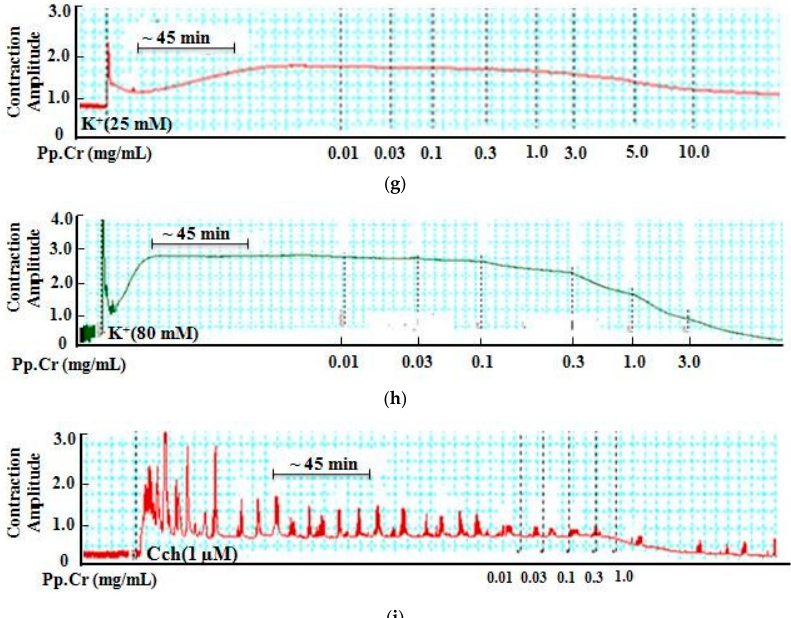
Figure 1. HPLC chromatogram acquired at 254 nm of the extract of P. perlatum ( a ). Tracing showing rhythmic spontaneously contracting isolated rabbit jejunum preparation ( b ), contracting effect of Cch (1 µM) on rabbit jejunum preparations (spasmogenic effect) ( c ), relaxant effect of atropine (0.3 and 1.0 µM) on Cch-induced (0.01, 0.03, 0.1, 0.3, and 1.0 µM) jejunum contraction ( d ), and relaxant effect of Pp.Cr (mg/mL) on spontaneously contracting jejunum with and without atropine ( e , f ), K + (25 mM)- ( g ) K + (80 mM)- ( h ) and Cch (1 µM)- ( i ) induced jejunum contractions.